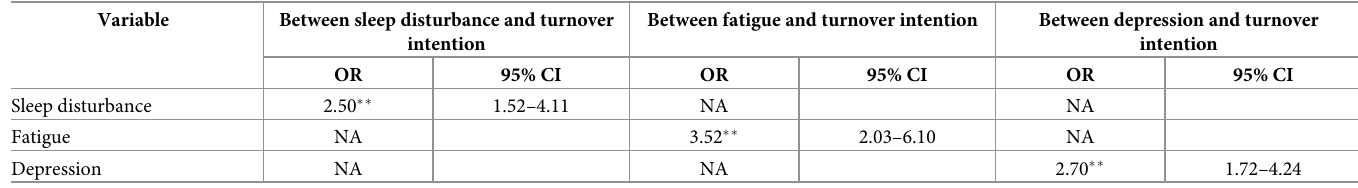
Table 2. Associations between health problems and turnover intention according to the multiple logistic model.